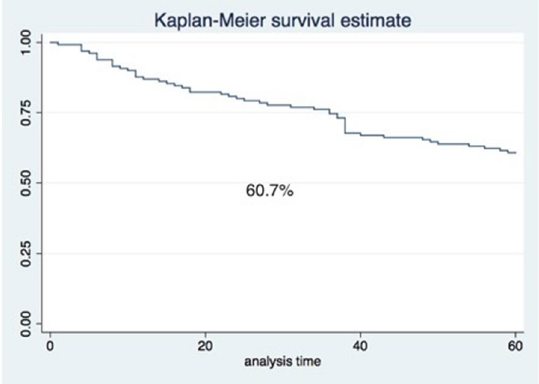
Fig. 2 Kaplan-Miere curve of overall survival (5 years) of oral tongue squamous cell carcinoma. Overall survival of 60.7% at 5 years